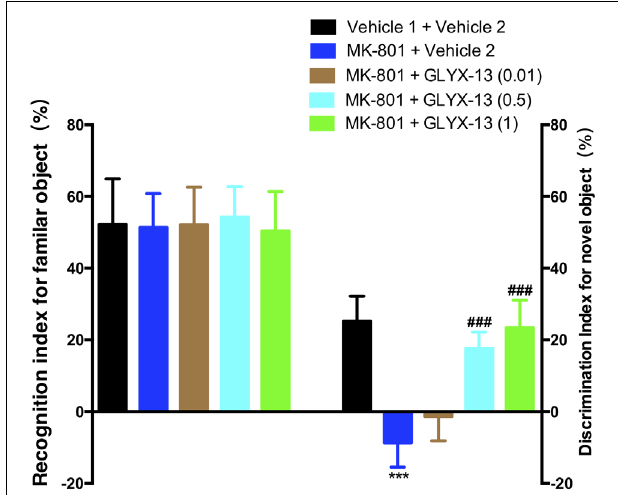
FIGURE 2 | Effects of GLYX-13 on MK-801-induced object recognition deficits in mice through NORT. The recognition index of the familiar objects and the discrimination index of the novel object are shown. Data represent the mean ± SEM ( n = 12 per group; ∗∗∗ P < 0.001, versus the vehicle 1 + vehicle 2-treated group; ### P < 0.001, versus the MK-801 + vehicle 2-treated